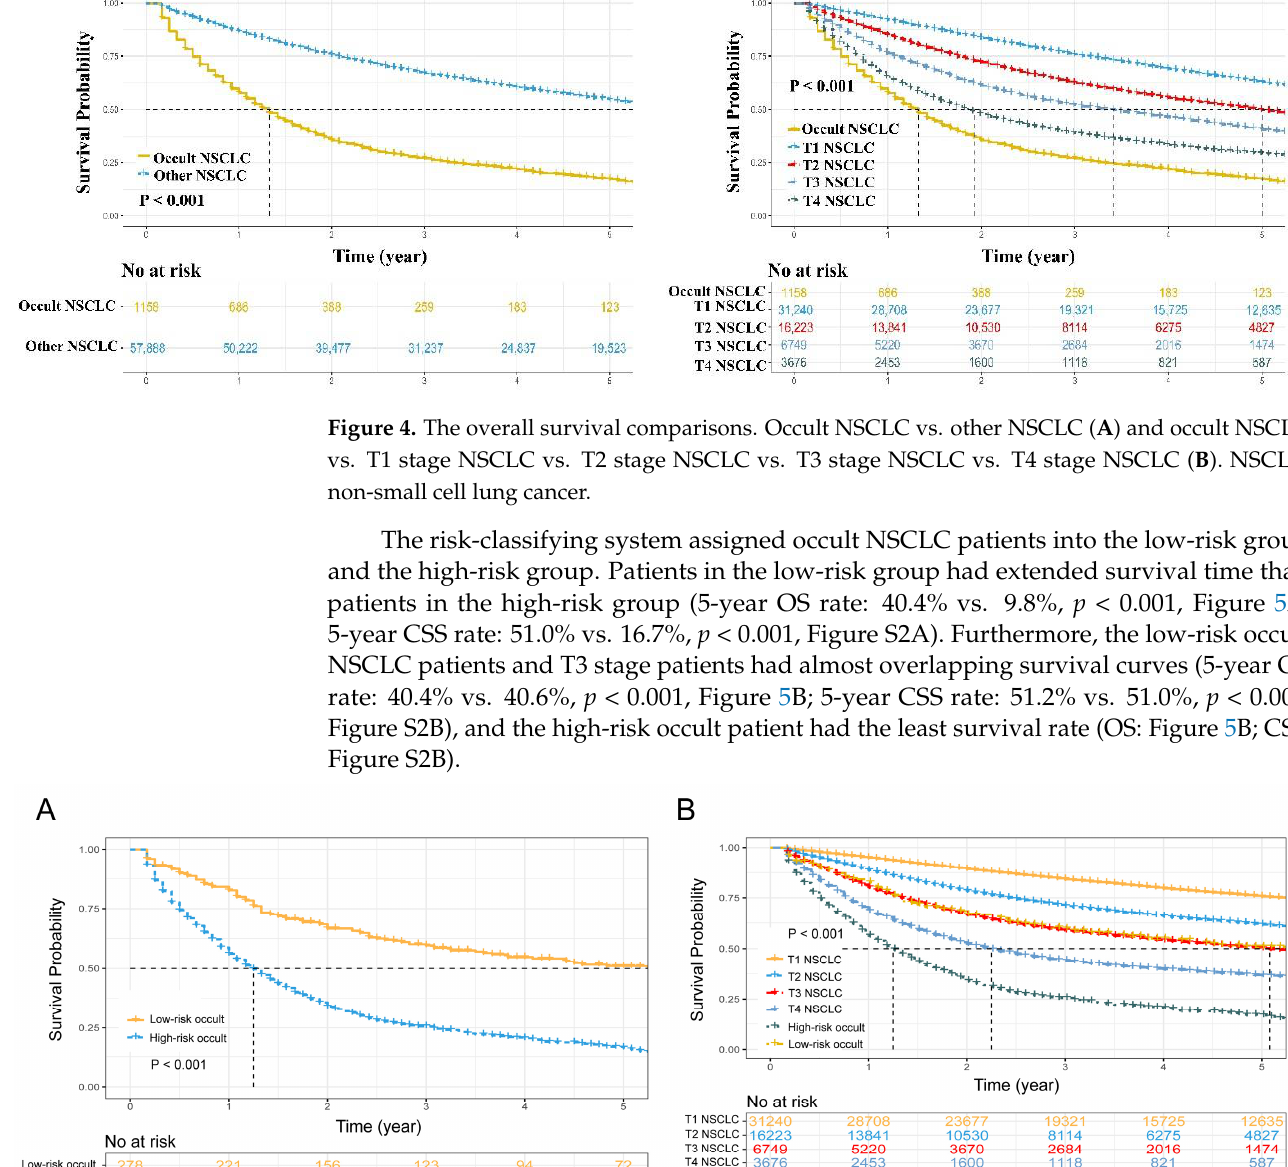
Figure 5. The overall survival comparisons. Low-risk occult NSCLC vs. High-risk occult NSCLC ( A ) and Low-risk occult NSCLC vs. High-risk occult NSCLC vs. T1 stage NSCLC vs. T2 stage NSCLC vs. T3 stage NSCLC vs. T4 stage NSCLC ( B ). NSCLC, non-small cell lung cancer.